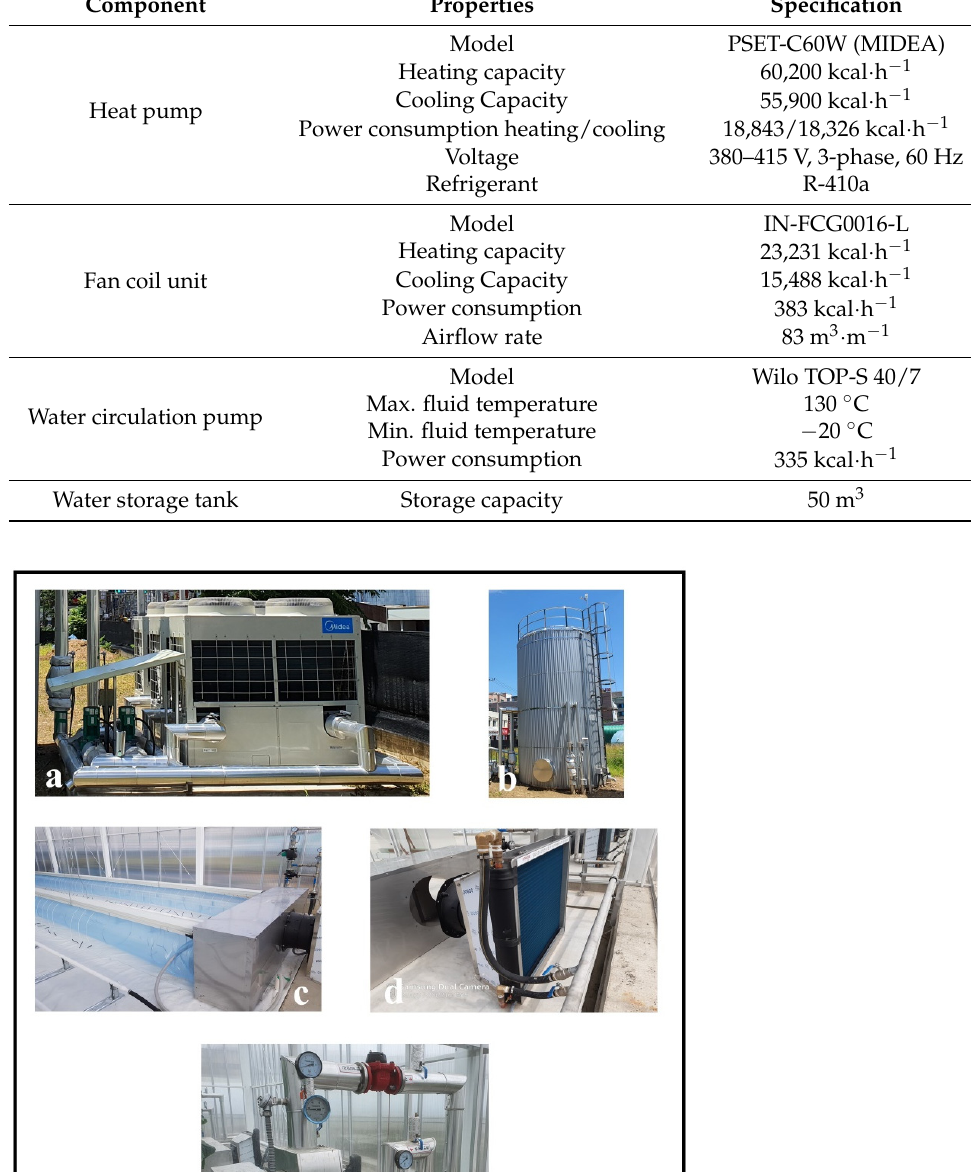
Table 1. Specification of AWHPs.